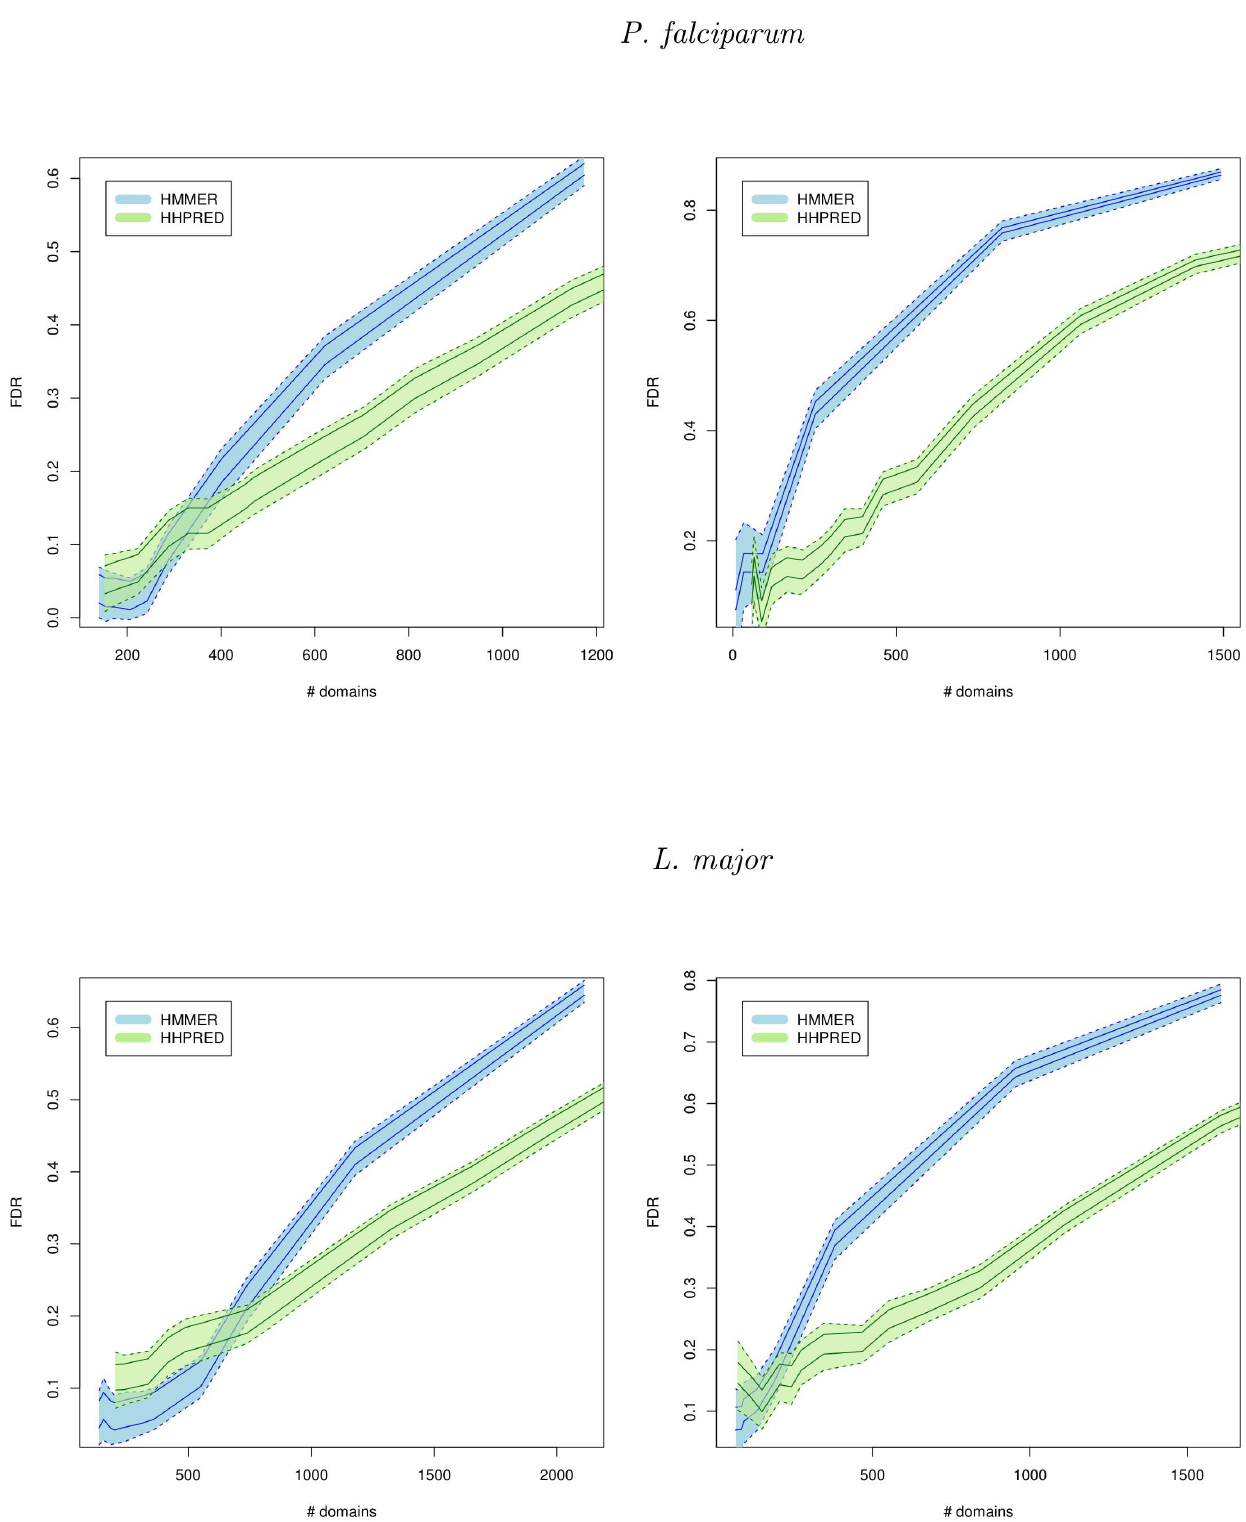
Figure 2. Sensitivity and accuracy of HHPRED and HMMER for P.falciparum and L.major . Number of new domains (x-axis) identified by HHPRED (green) and HMMER (blue) using local (left) and global (right) alignments for various FDRs (y-axis). For each approach, the two plain lines represent an upper and lower FDR estimate (see Methods for details). Dashed lines represent the standard error associated with these two estimates. For the sake of clarity, only the standard error above (resp. below) the upper (resp. lower) FDR estimate are represented here.